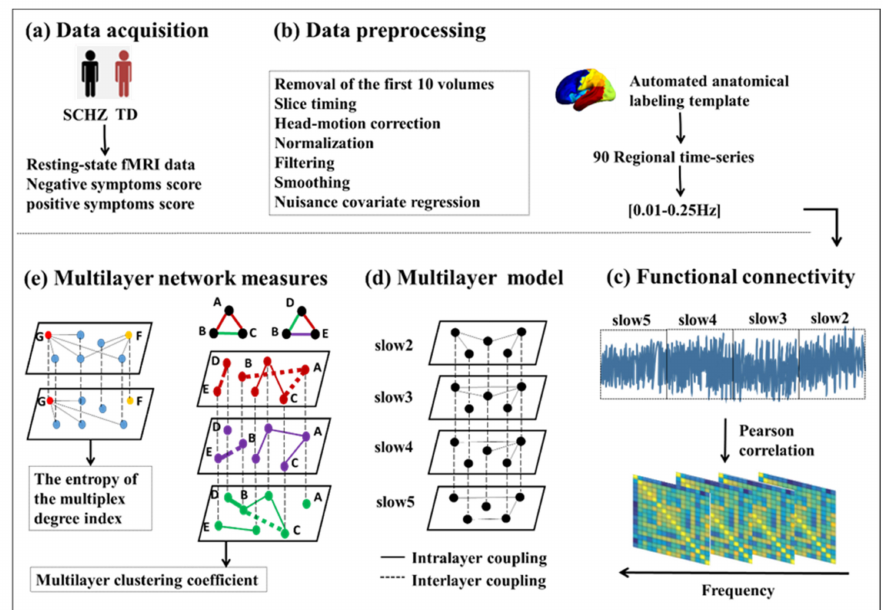
Figure 1. Schematic overview of the analysis strategy. ( a ) The resting-state fMRI data of schizophrenia (SCHZ) and typical development (TD) were obtained. At the same time, the negative and positive symptom scores of the patients were obtained. ( b ) This panel describes the preprocessing procedure of data, and brain signals of 0.01–0.25 Hz were obtained. ( c ) The brain signals between 0.01 and 0.25 Hz were decomposed into four frequency bands (slow2–slow5), and Pearson correlation was used to establish intralayer functional connections. ( d ) The corresponding nodes are considered connected between different layers. In this way, a multilayer frequency network model was constructed. ( e ) Multilayer network measures were